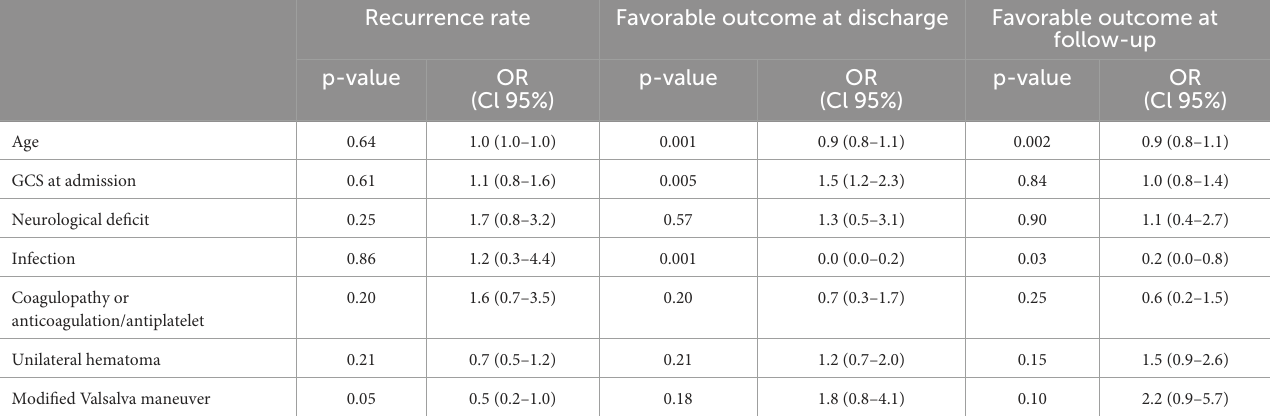
TABLE 4 Adjusted logistic regression outcome analysis by variables with potential influence on relation between MVM and recurrence/outcome at discharge as well as at